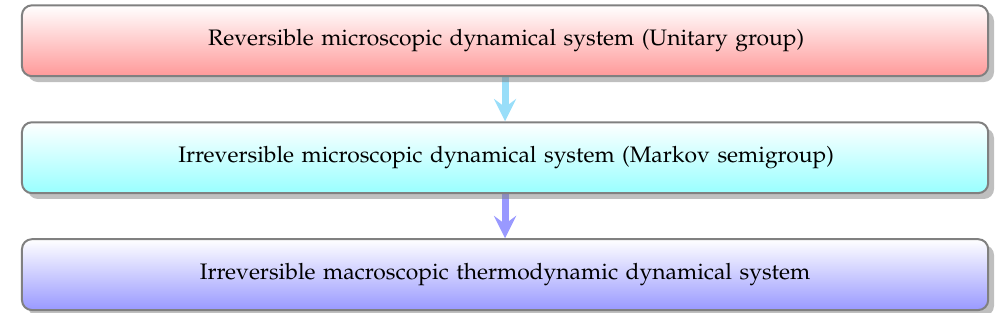
Figure 1. The three-step Prigoginean process of recovering the macroscopic dimension of thermody- namic experience from the microscopic